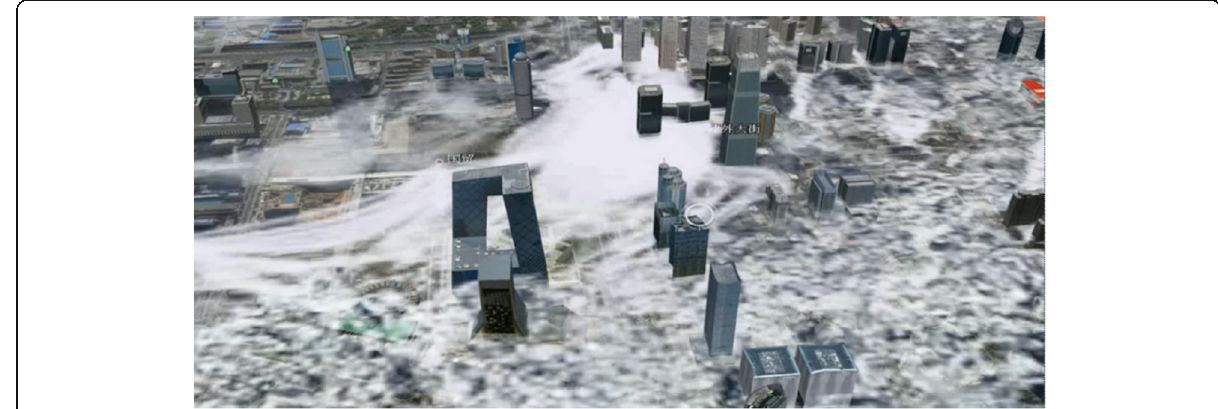
Fig. 2 Design sketch of data visualization based on Google